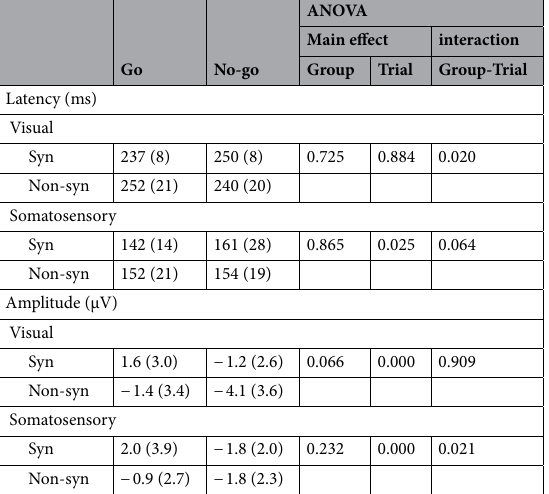
Table 3. Mean values for latencies and amplitudes of N2 component in synesthete and non-synesthete groups with SD. Syn Synesthete; Non-syn Non-synesthete. Right rows indicate the results of